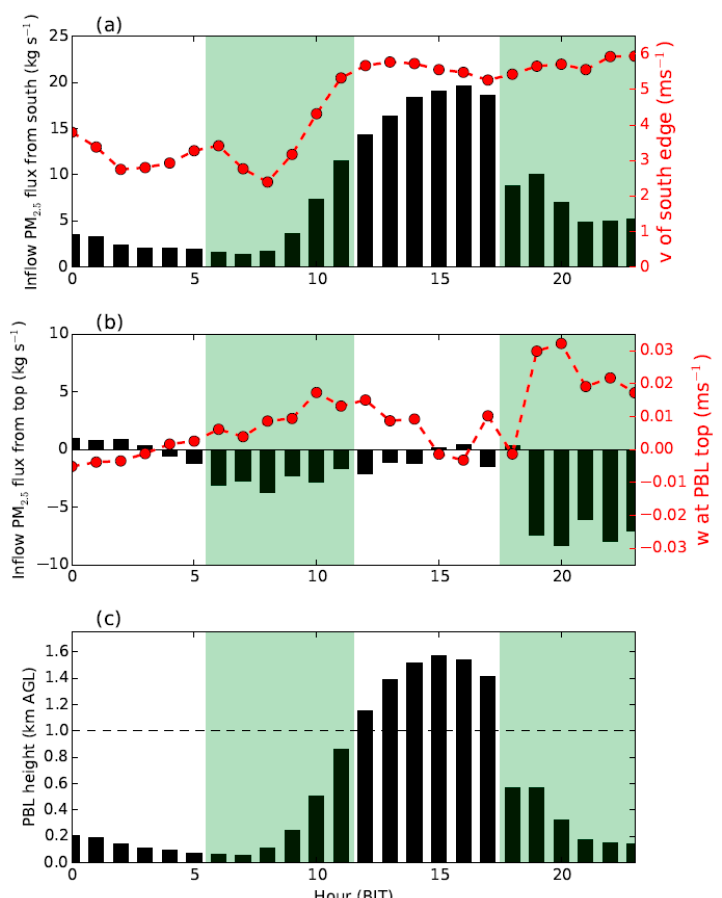
Figure 12. Time series of ( a ) inflow of the PM 2.5 flux (black bars) within the PBL from south to the ROI in Beijing and the average v-component of horizontal wind (in red) on the south edge; ( b ) inflow of the PM 2.5 flux (black bars) from top to the ROI and the average vertical velocity (w, in red) at the PBL top level; and ( c ) the average PBL height over the ROI. The locations of ROI are denoted by the blue square in Figure 1b. The green shaded areas indicate the approximate periods when the PBL over Beijing is influenced by the LLJ above.